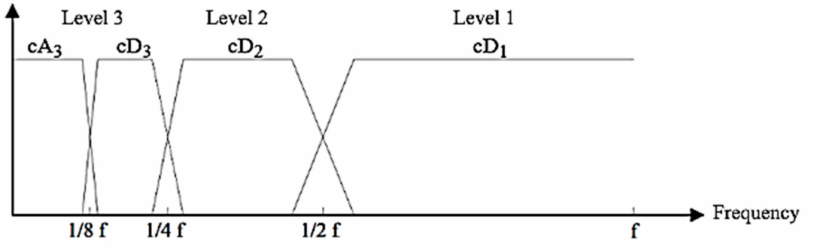
Figure 2. Symbolic representation of filter frequency responses for three level decomposition.